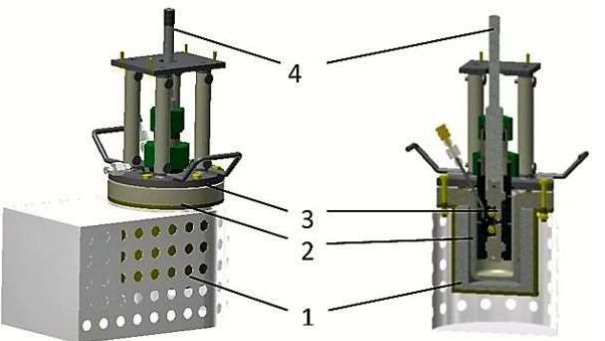
Figure 3. LILETIN facility: 1—furnace, 2—liquid lead vessel, 3—specimen fixing assembly, and 4—rod.